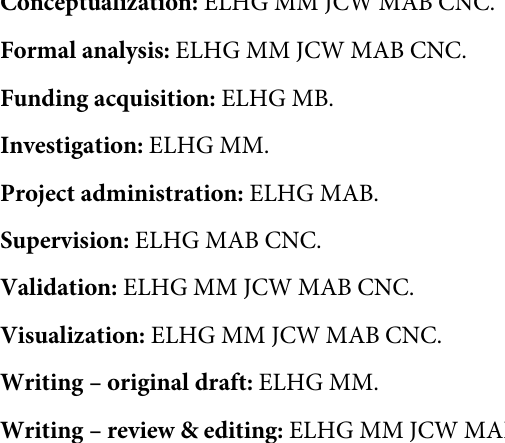
S2 Fig. Frequency of use of information sources and evidence categories by Brazilian man- agers of protected areas. (PDF) S3 Fig. Accessibility and importance of evidence categories reported by Brazilian managers of protected areas. S1 Table. Number and size of Brazilian protected areas and questionnaire response rates. (PDF) S2 Table. Factors that may influence managers of Brazilian protected areas in the search for relevant information for management related actions. S3 Table. Details of model selection for evidence based decision making scores as a func- tion of several potential predictors. (PDF) S1 Text. Questionnaire submitted to managers of Brazilian protected